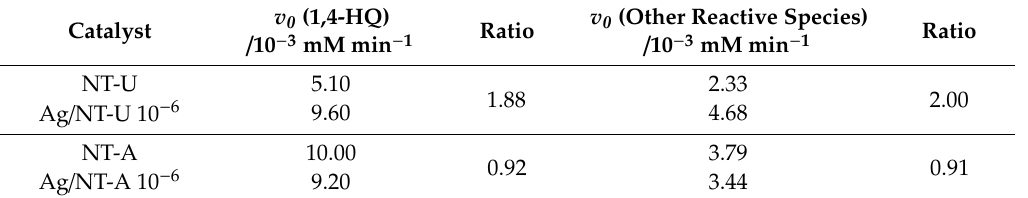
Table 2. Ratios (Ag / NT: NT) of 1,4-HQ degradation and coumarin reaction with other reactive species. Catalyst